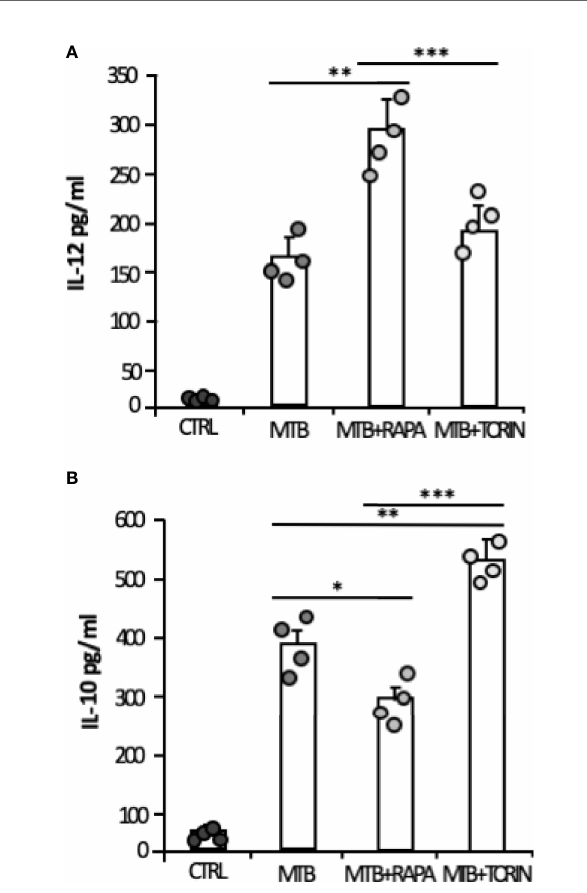
FIGURE 6 | Effect of mTORC1 or mTORC1/mTORC2 inhibition on IL-12 and IL-10 cytokine production in Mtb-infected DC. DC were left untreated (CTRL) or stimulated for 20 h with rapamycin (RAPA) or infected for 24 h with Mtb (MTB) and treated or not with rapamycin (MTB+RAPA, added 4 h post infection) or with Torin1 (MTB+TORIN, added 4 h after infection). Secreted IL- 12 (A) and IL-10 (B) were quanti fi ed by using In fl ammatory Cytokine bead array kit. The results represent mean values ± standard error of 4 independent experiments. Circles represents values obtained, for the speci fi ed cytokine, from each single donor/experiment. Signi fi cance was calculated by analysis of variance (ANOVA) followed by multiple comparison performed with Tukey ’ s test as speci fi ed in Materials and Methods section.